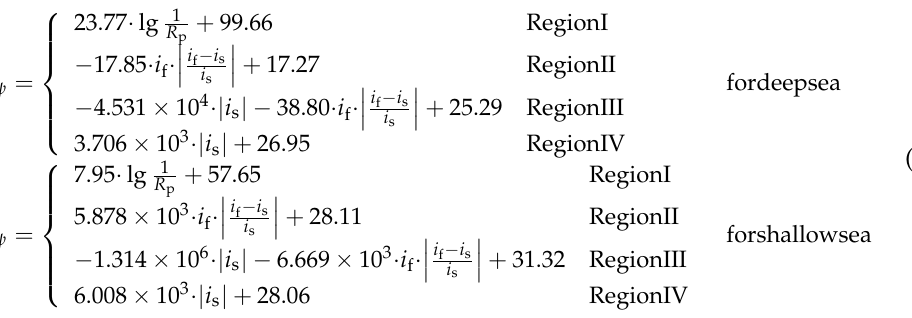
Figure 18. Schematic diagram for slip-dissolution mechanism ( a ) and hydrogen embrittlement mechanism ( b ) in the deep